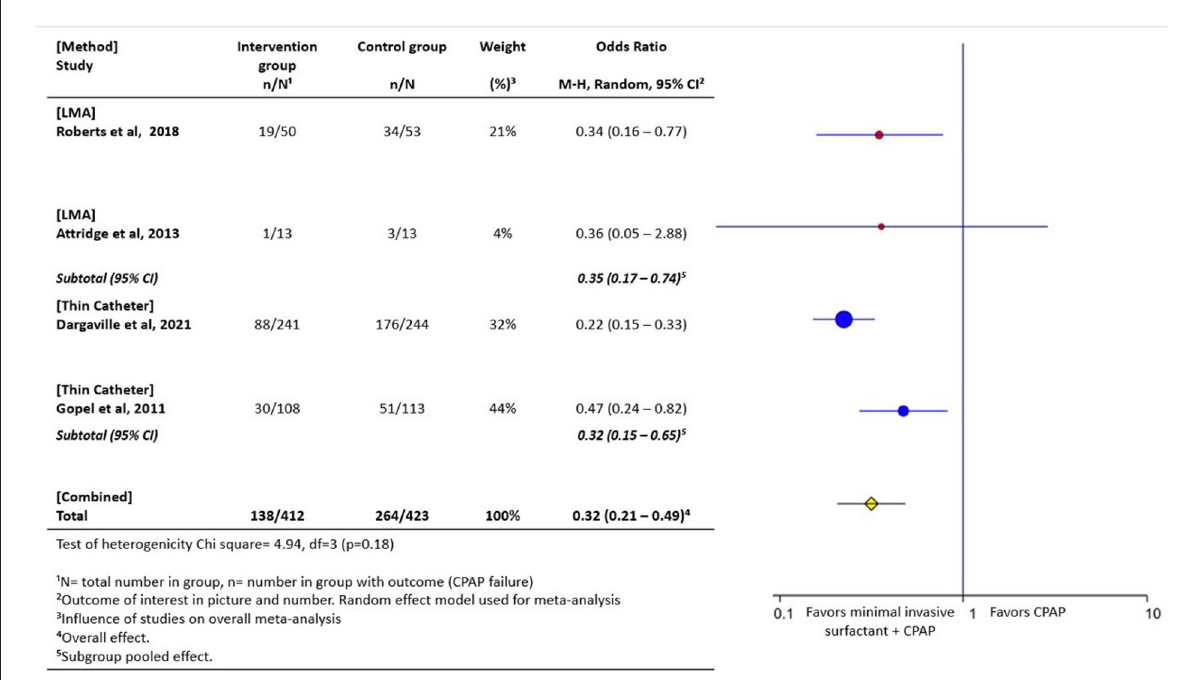
FIGURE3 Forest plot of comparison of CPAP plus minimally invasive surfactant administration via thin catheter or laryngeal mask airway (LMA) vs. CPAP only. The outcome of interest was CPAP failure as determined by need for intubation. These minimally invasive techniques are associated with a 47% risk reduction in CPAP failure (142–144,